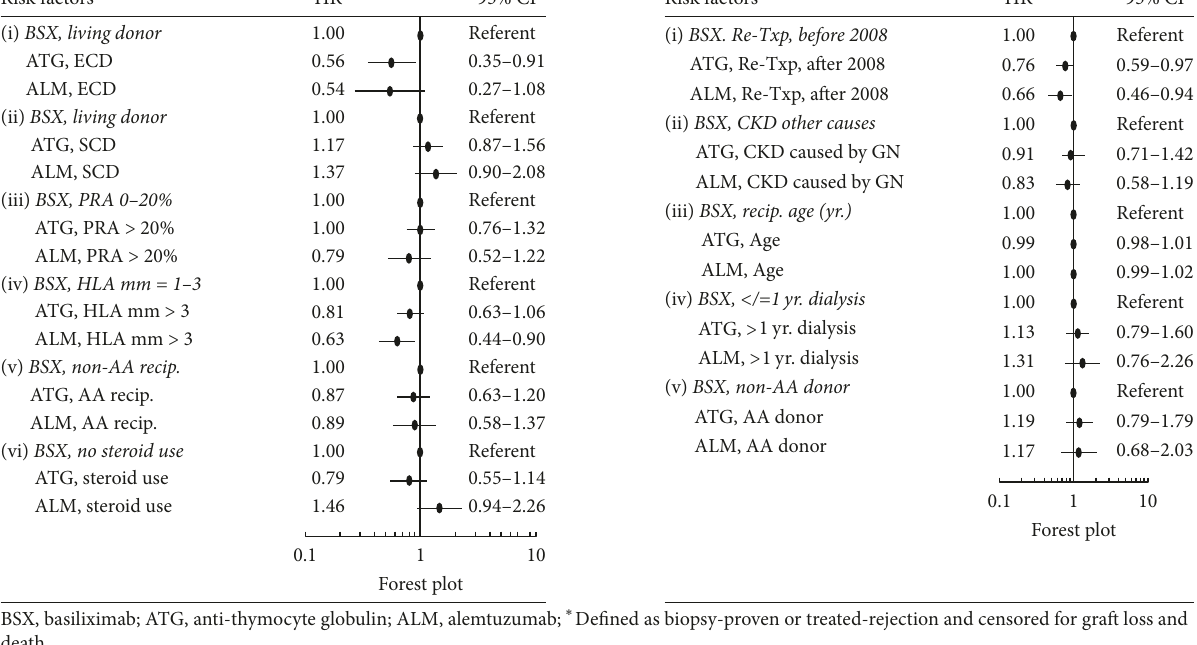
Figure 4: Acute rejection ∗ in first year of kidney retransplant, Cox model with